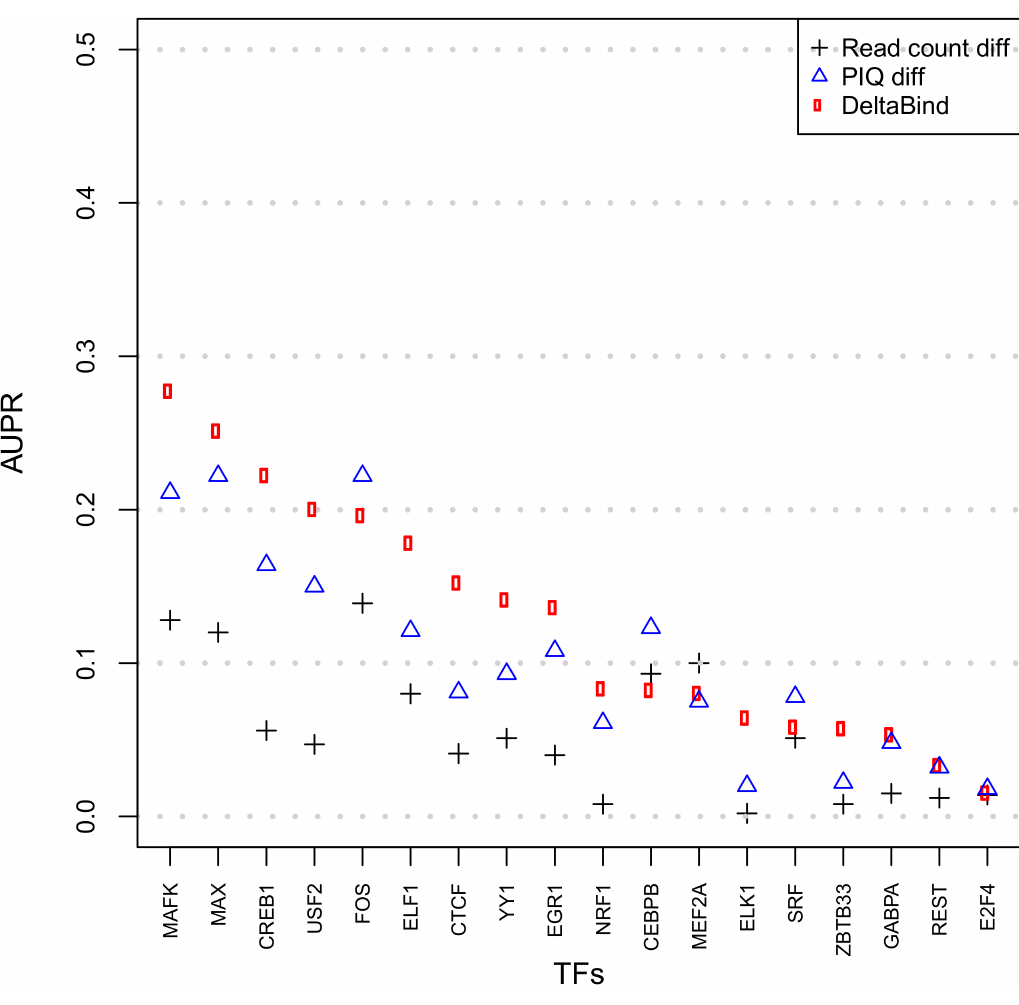
Table 1 summarizes information about the factors used in the prediction and the prediction performance. For each factor, the number of ground truth differential sites, number of candi- date sites and their ratios are shown. For the prediction accuracy, AUPR, AUC and precision values are shown.